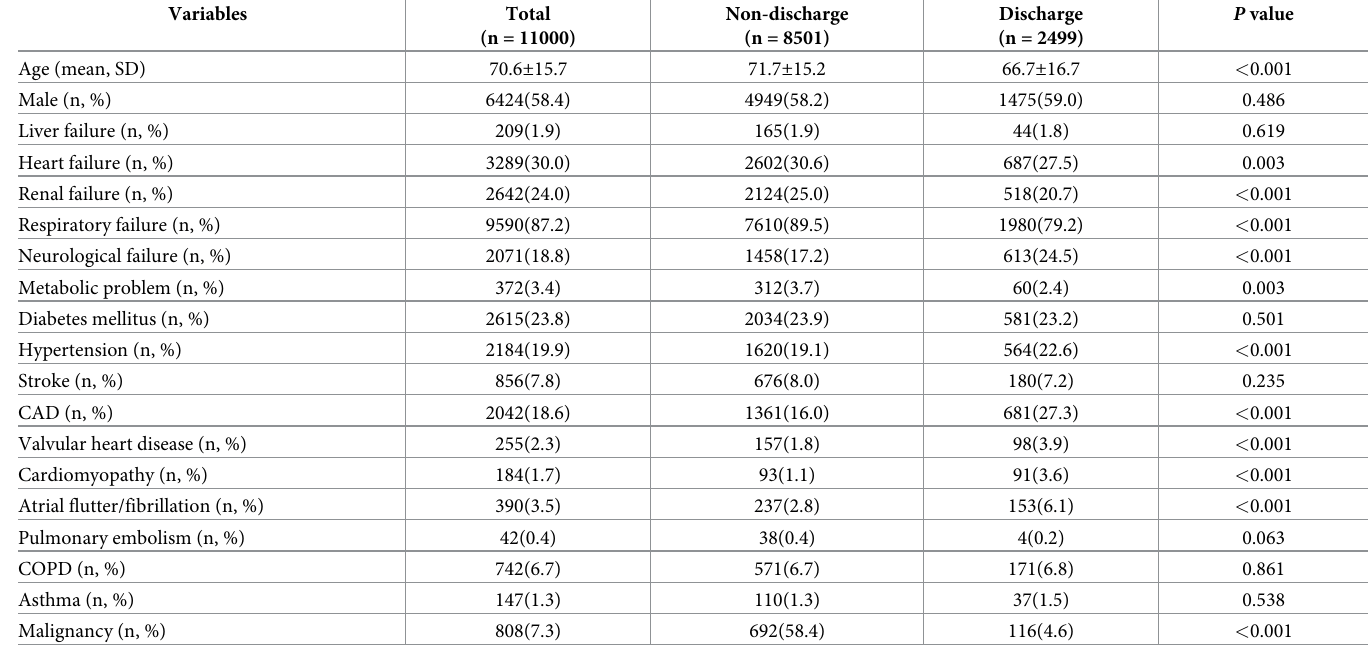
Table 1. Demographic and clinical characteristics of hospitalized OHCA